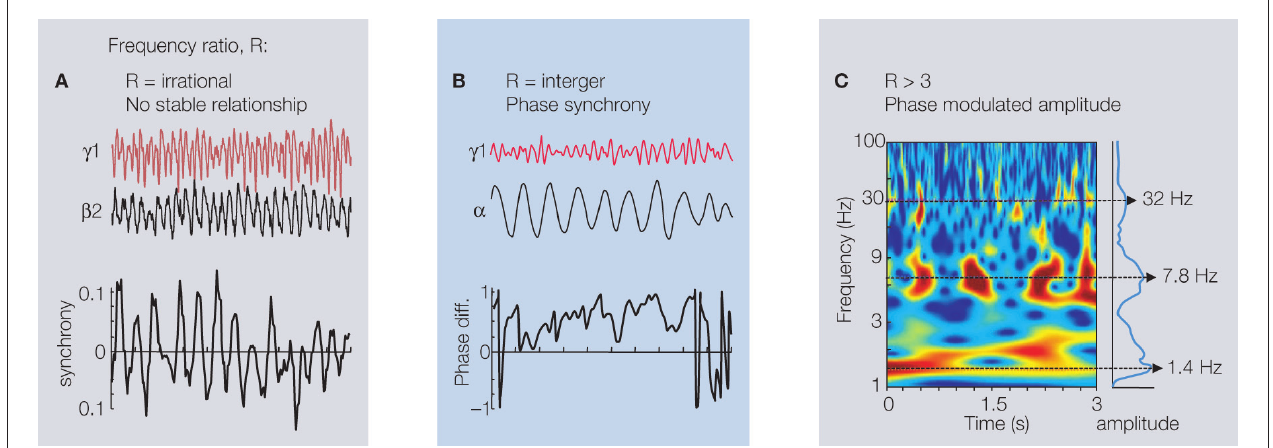
Figure 2 | Examples of commonly observed stationary interactions between different, concurrently generated rhythms in neocortex. (A) When frequency ratio (R) is irrational the phase relationship between two concurrently generated frequencies is non-stationary. Traces show LFP activity in superficial and deep cortical laminae during concurrent γ 1 and β 2 rhythm expression (Roopun et al., 2008). In this case average synchrony between oscillators is near-zero, with a periodic change in instantaneous phase corresponding to the sum of the periods of the two rhythms shown. (B) When R is an integer a stable phase difference can be seen between the two rhythms recorded from single or pairs of brain regions. The